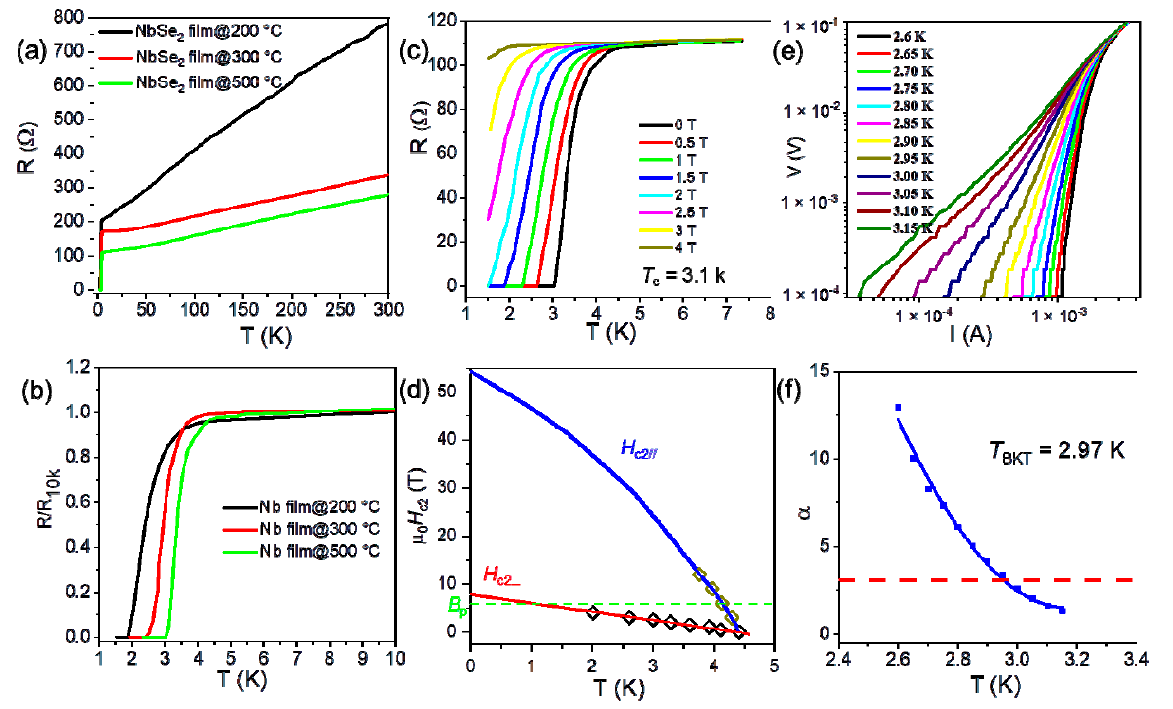
Figure 3. ( a , b ) Superconductivity of the NbSe 2 films at the different sputtering temperatures; ( c ) the superconducting resistance transition of the NbSe 2 film under an out-of-plane magnetic field; ( d ) temperature-dependence of the upper critical field H c2 under out-of-plane (red line) and in-plane (blue line) magnetic fields, the dashed green line indicates the Pauli limit field B p = 5.7 T; ( e ) voltage–current (V–I) characteristics at different temperatures on a logarithmic scale; and ( f ) the corresponding BKT transition.